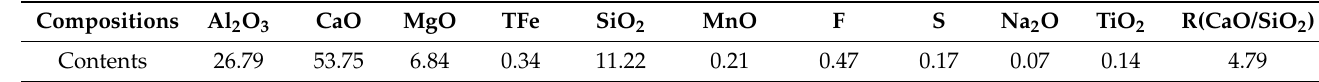
Table 1. Composition of refining slag (mass